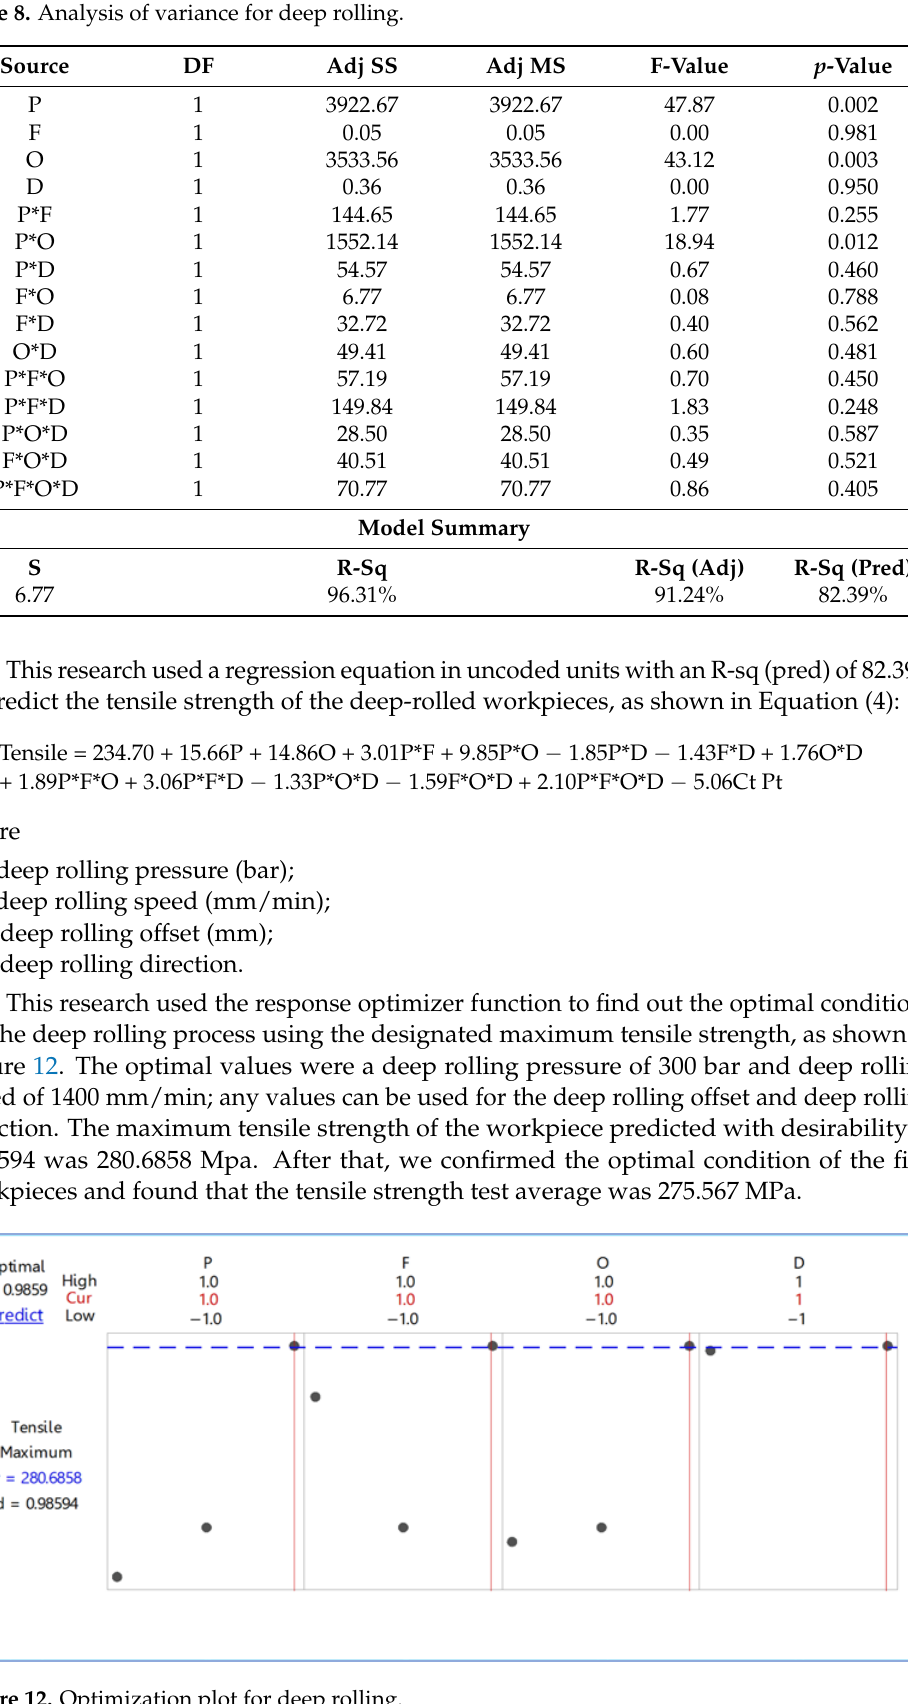
Figure 12. Optimization plot for deep